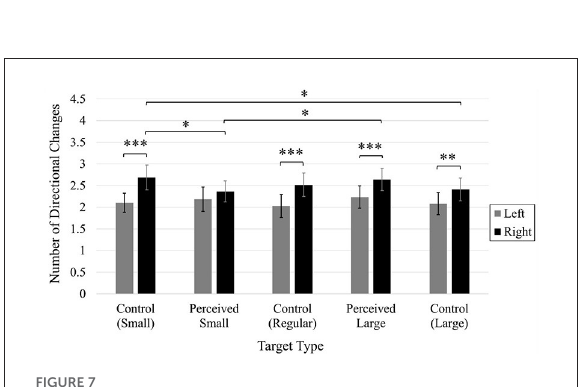
FIGURE7 Average number of directional changes. Error bars represent 95% confidence intervals. * p < 0.05, ** p < 0.01, *** p <